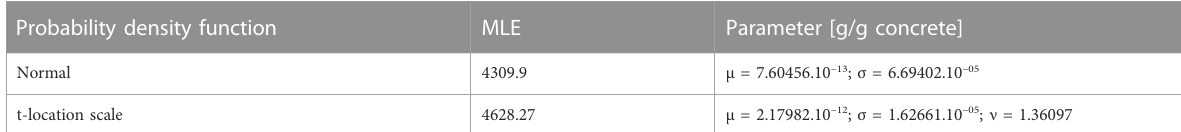
TABLE 4 Maximum likelihood estimate and parameters of the probability density function for error distribution modeling.